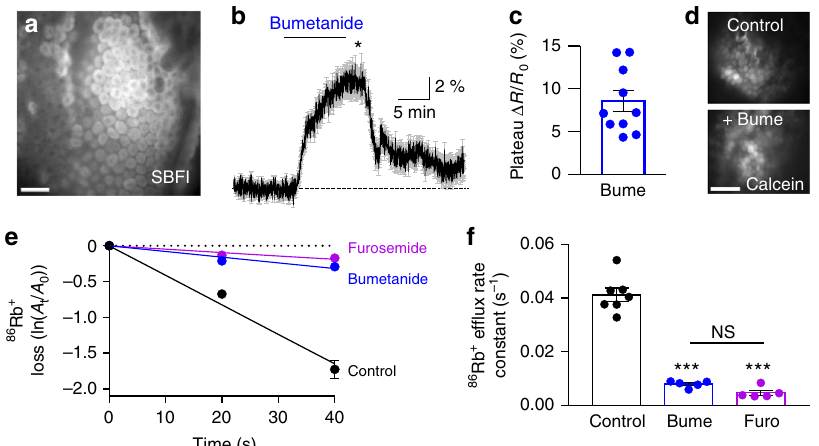
Fig. 4 NKCC1 is poised for outward transport in the luminal membrane. a Image of SBFI fl uorescence of the choroid plexus taken with wide- fi eld fl uorescence microscope. Scale bar = 40 µ m. b Representative sodium signals of choroid plexus during 10 min baseline, 10 min application of the NKCC1 inhibitor bumetanide (10 μ M), and 20 min washout. Gray lines represent the SBFI ratio obtained from 40 single cells during one experiment, black line represents an average of these cells. c Average bumetanide-induced increase in SBFI ratio of choroid plexus cells, indicative of increased intracellular sodium concentration ( n = 10 CPs from ten mice). d Representative images of calcein fl uorescence of the choroid plexus either after 10 min in aCSF (top panel) or after 10 min of bumetanide treatment (bottom panel, time point marked as * in b ). Scale bar = 40 µ m. e Loss of 86 Rb + from choroid plexus as a function of time in control settings (black, n = 7 CPs from seven mice) or with treatment of either bumetanide (20 μ M, blue, n = 5 CPs from fi ve mice) or furosemide (1 mM, violet, n = 5 CPs from fi ve mice). Y -axis is the natural logarithm of amount of 86 Rb + left in choroid plexus at time t ( A t ) divided by the amount at time 0 ( A 0 ). f Ef fl ux rate constants for 86 Rb + in control (0.041 ± 0.003 s − 1 , n = 7 CPs from seven mice), in the presence of bumetanide (0.008 ± 0.001 s − 1 , n = 5 CPs from fi ve mice), or furosemide (0.005 ± 0.001 s − 1 , n = 5 CPs from fi ve mice). Error bars represent standard error of the mean and statistical signi fi cance was tested with one-way ANOVA followed by Tukey ’ s multiple comparisons test and the asterisks above the bars indicate comparison to the control while the comparison between the two test solutions is indicated with a line above the relevant bars. *** P < 0.0001, NS not signi fi cant ( P =